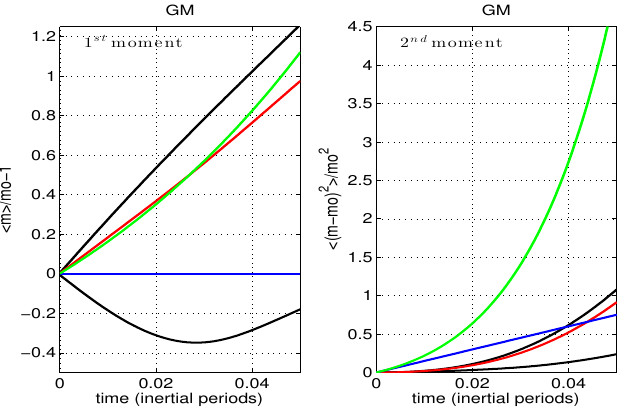
Figure 4. First and second moments vs time for the high dimensional system (red and black) with prediction based upon the coupled oscillator paradigm (46) (green). The red line represents the ensemble average of the moments. The black lines are ensemble averages conditioned on the sign of the wavenumber tendency (velocity in wavenumber space) at t = 0. The blue line represents a constant diffusivity model. Upper left (upper right, lower left) panels are 10 − 2 e GM o (10 − 1 e GM o , 10 0 e GM o ). Left hand panels are the first moment. Right hand panels are the second moment. Differences in the conditioned moments (black lines) reflect a decorrelation time scale from which one can infer a “jump” time scale, Section 3.2.4 and Figure 9.